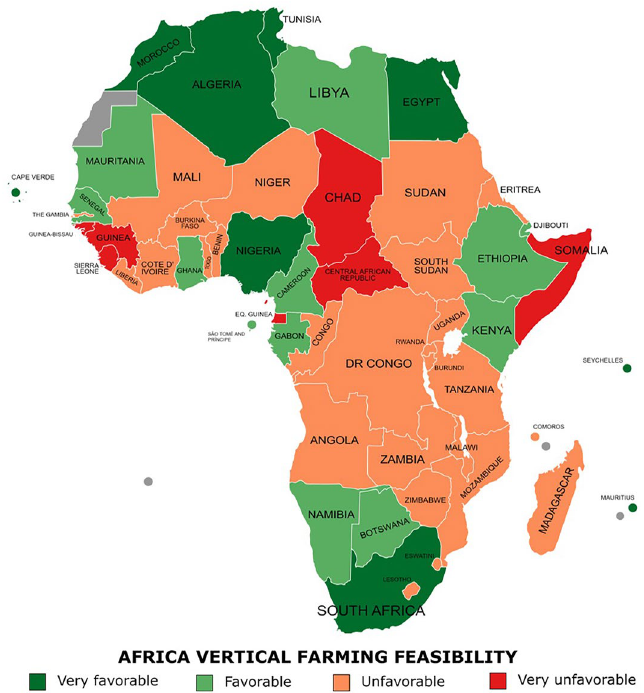
Figure 5. Categorization of African countries according to feasibility of vertical farming. Synthetic feasibility index (SFI) categorized in very favorable (> 0.453); favorable (0.453–0.363); unfavorable (0.363–0.273); very unfavorable (< 0.273) (generated with MapChart, https:// www. mapch art.